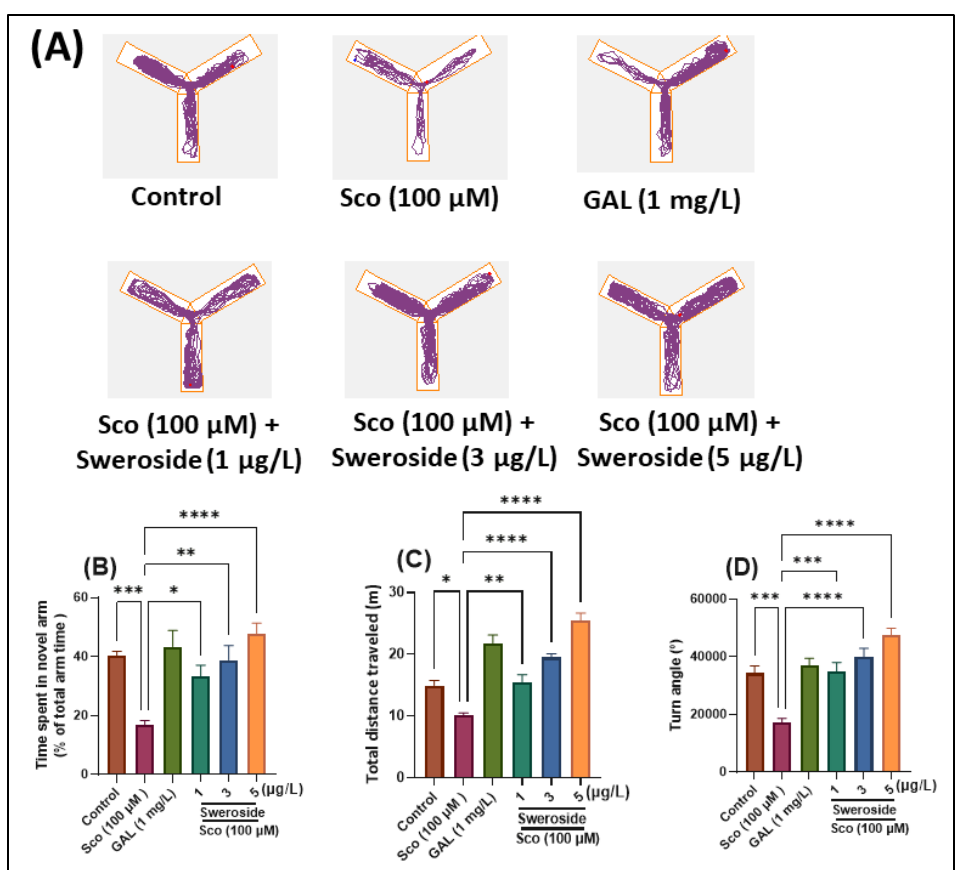
Figure 2. Assessment of response to novelty in Sco-treated zebrafish subjected to sweroside treatment at doses of 2.79, 8.35, and 13.95 nM in the Y-maze test. ( A ) Representative tracking locomotion patterns in various groups; ( B ) Time spent in the novel arm (% of total arm time); ( C ) Total distance traveled (m); ( D ) Turn angle (°). Data are presented as means ± S.E.M. ( n = 10 animals per group). * p < 0.01, ** p < 0.001, *** p < 0.0001, and **** p < 0.00001 (Tukey’s post hoc analyses). Galantamine (GAL, 2.71 μ M) was used as a reference positive drug.